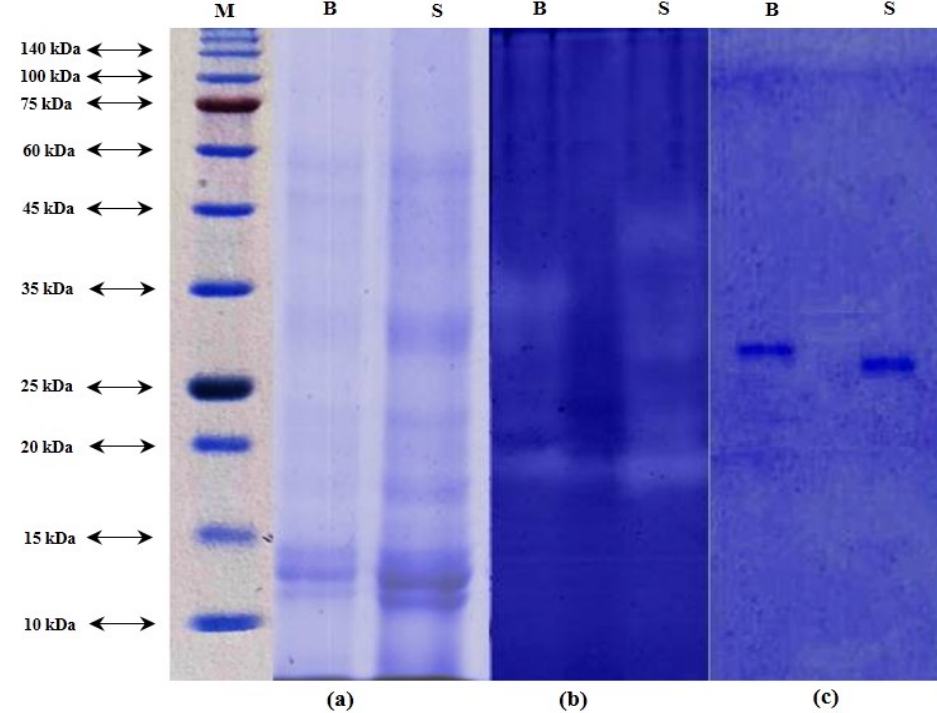
Figure 1. SDS–PAGE ( a ), zymography ( b ), and inhibitory activity staining ( c ) of the intestinal crude extract (ICE) of Huso huso and Acipenser stellatus . ( a ): Molecular weight marker (M); ICE from Huso huso intestine (B); ICE from Acipenser stellatus intestine (S). Coomassie blue G-250 (0.1%) was used for staining proteins from SDS-PAGE. Zymogram activity and inhibitory activity staining were stained by using 0.1% Coomassie blue R ‐ 250.